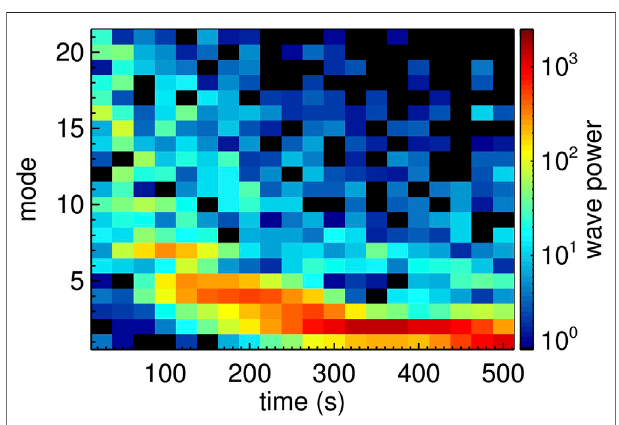
FIGURE 3 | Growth of KH, showing inverse cascade (Delamere et al., 2011).